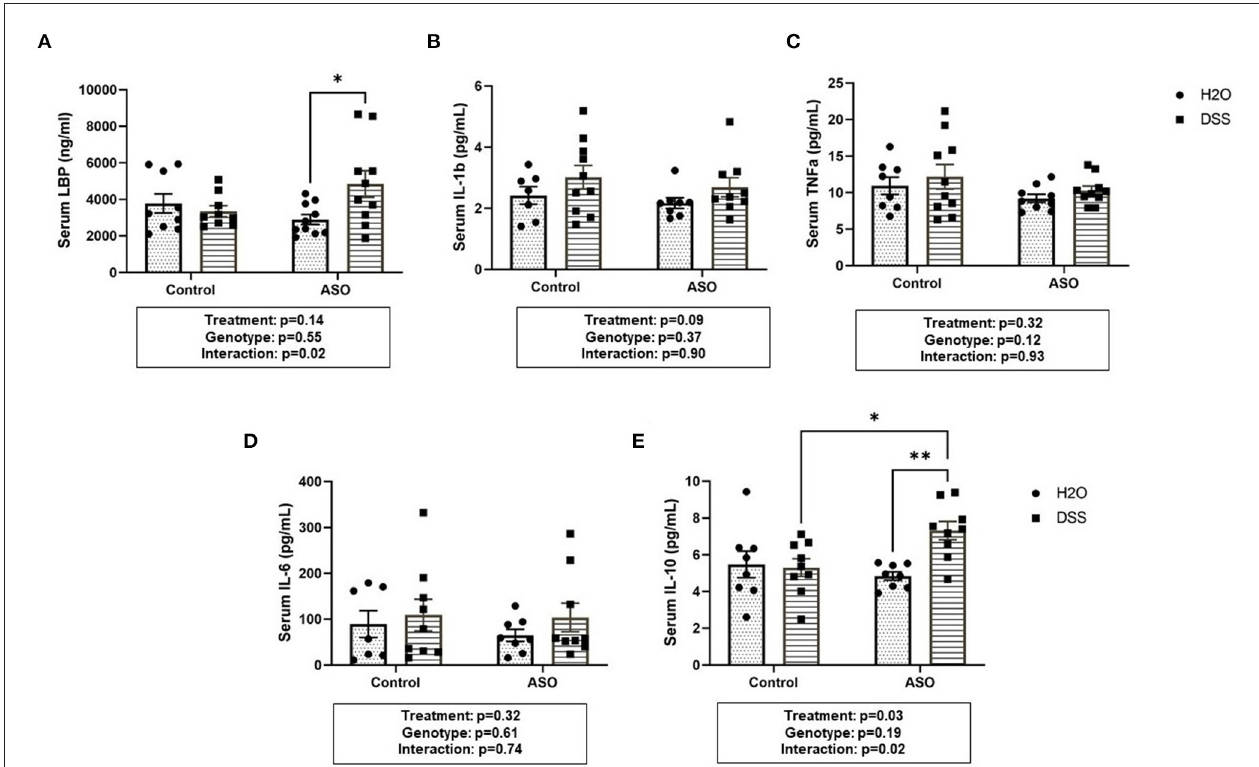
FIGURE 7 | Systemic Inflammation Markers. (A) Serum LBP was higher in ASO mice that received DSS although this failed to reach statistical significance. However, there was significance in the interaction between genotype and treatment ( p = 0.0240). Data are presented as means (ng/ml). There was no significant elevation of systemic inflammatory cytokines in DSS treated control or ASO mice including (B) IL-1b, (C) TNFa, and (D) IL-6 the three key markers in systemic inflammation. (E) Only DSS treated ASO mice displayed significantly ( p = 0.0328) increased serum IL-10. Outliers were omitted prior to analysis ( > 2 standard deviations from the mean). Two-way ANOVA was conducted and values for different factors are indicated in the graphs followed by post-hoc Tukey which is indicated on each graph when appropriate * p < 0.05, ** p < 0.01. ASO, α -synuclein overexpressing; LBP, Lipopolysaccharide binding